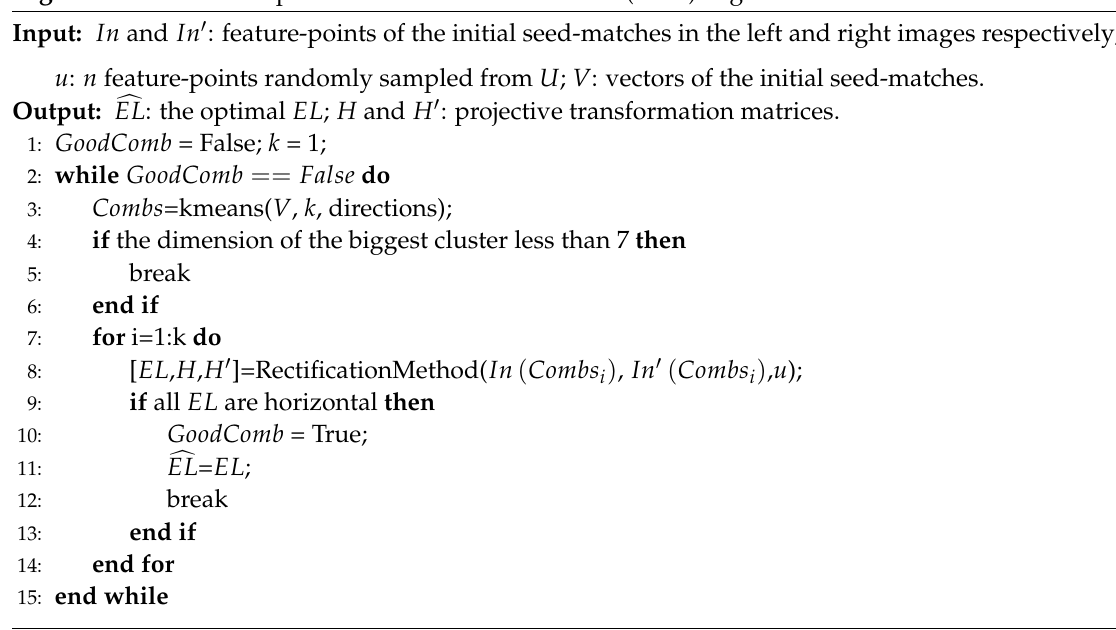
Algorithm 1 The Correspondence-Direction-Constraint (CDC)